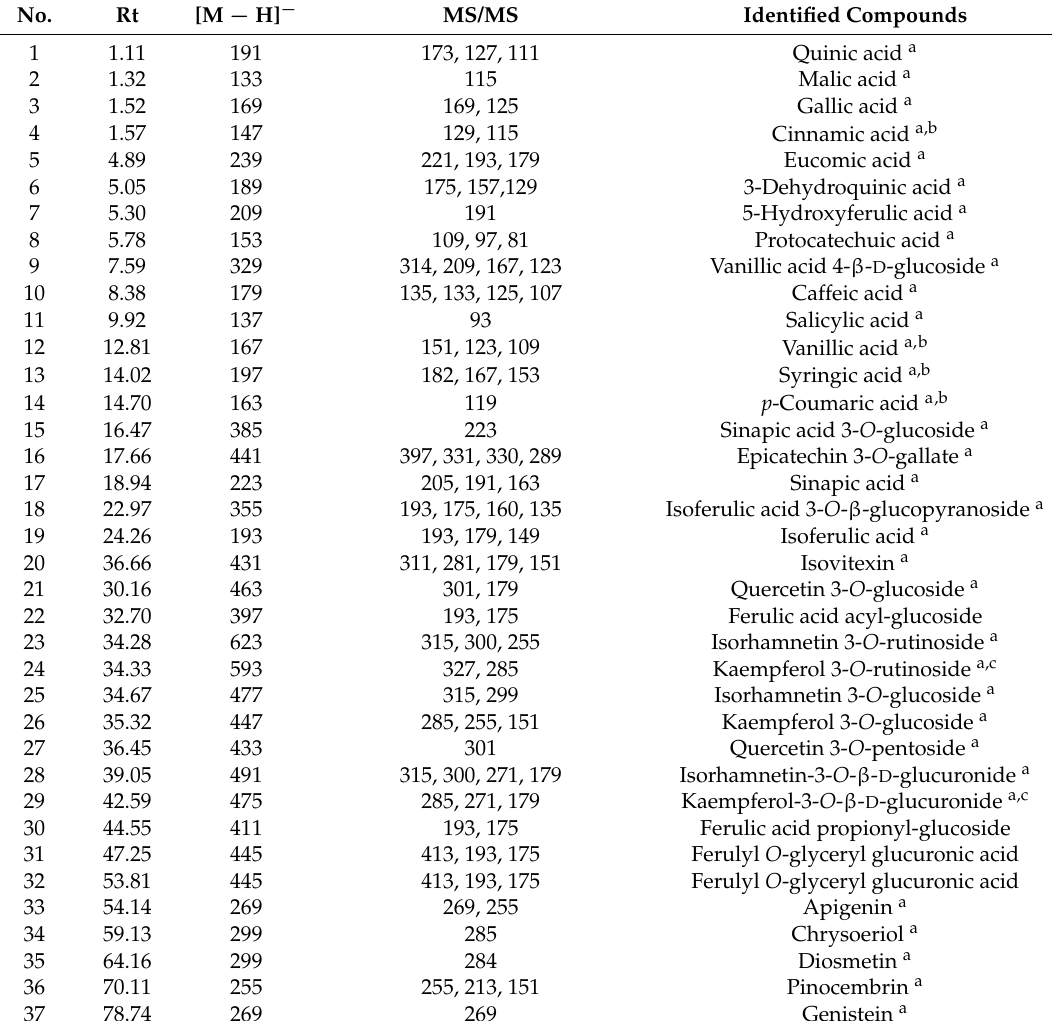
Table 1. Phenolic compounds in the methanol extract via negative